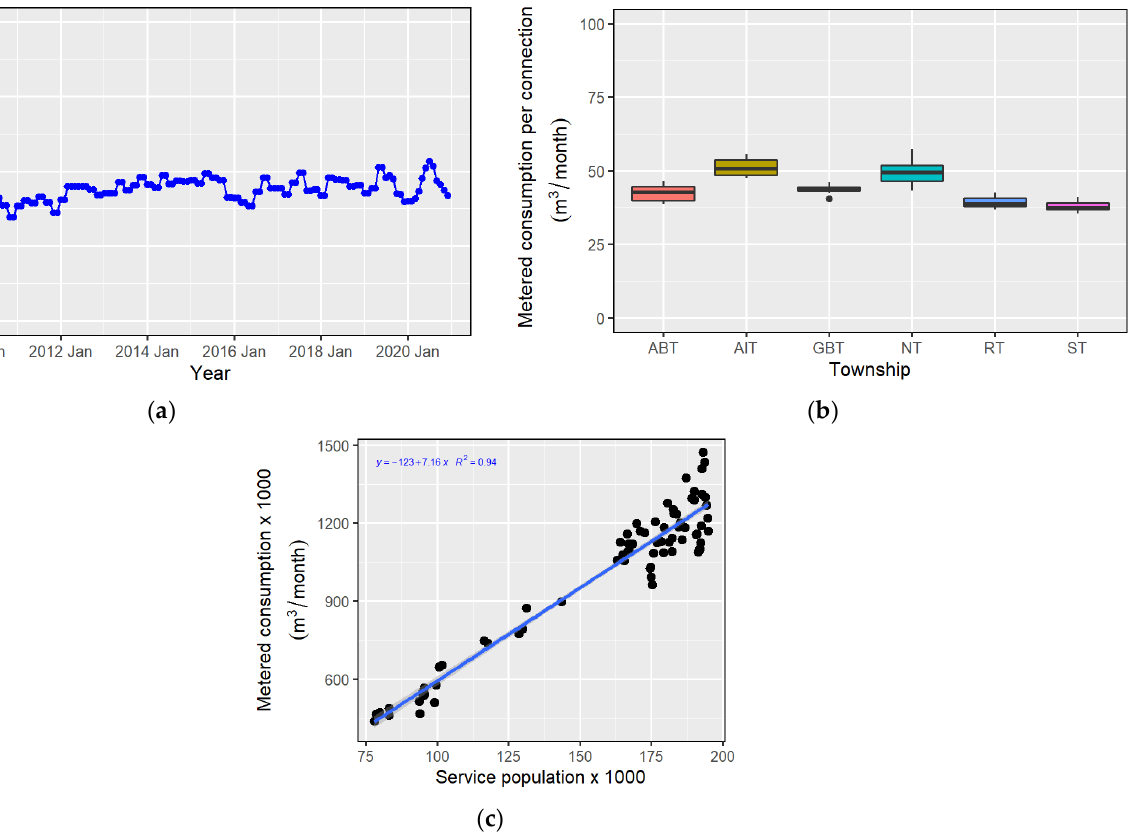
Figure 4. Metered water consumption per connection: ( a ) time-series in Tajpura, ( b ) for the six townships in 2020, and ( c ) correlation between service population and metered consumption in Tajpura.